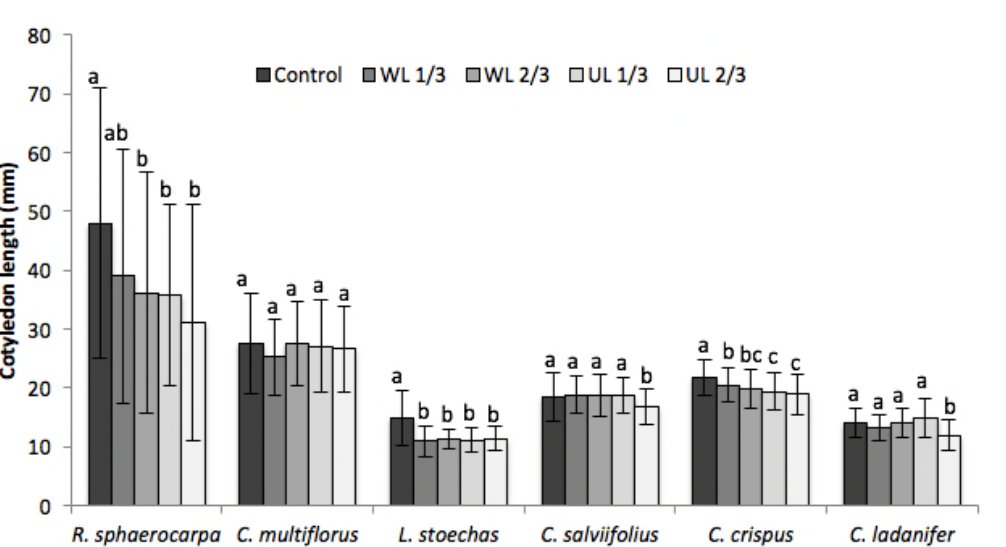
Figure 4. E ff ect of leaf litter on the cotyledon length of the analysed species in the five treatments (C: vermiculite control; WL, washed leaf litter; UL: untreated leaf litter; 1 / 3: 1.33 dm 3 of vermiculite and 0.66 dm 3 of leaf litter; 2 / 3: 0.66 dm 3 of vermiculite and 1.33 dm 3 of leaf litter). a, b, c: same letter means no significant di ff erence between treatments ( p > 0.05).